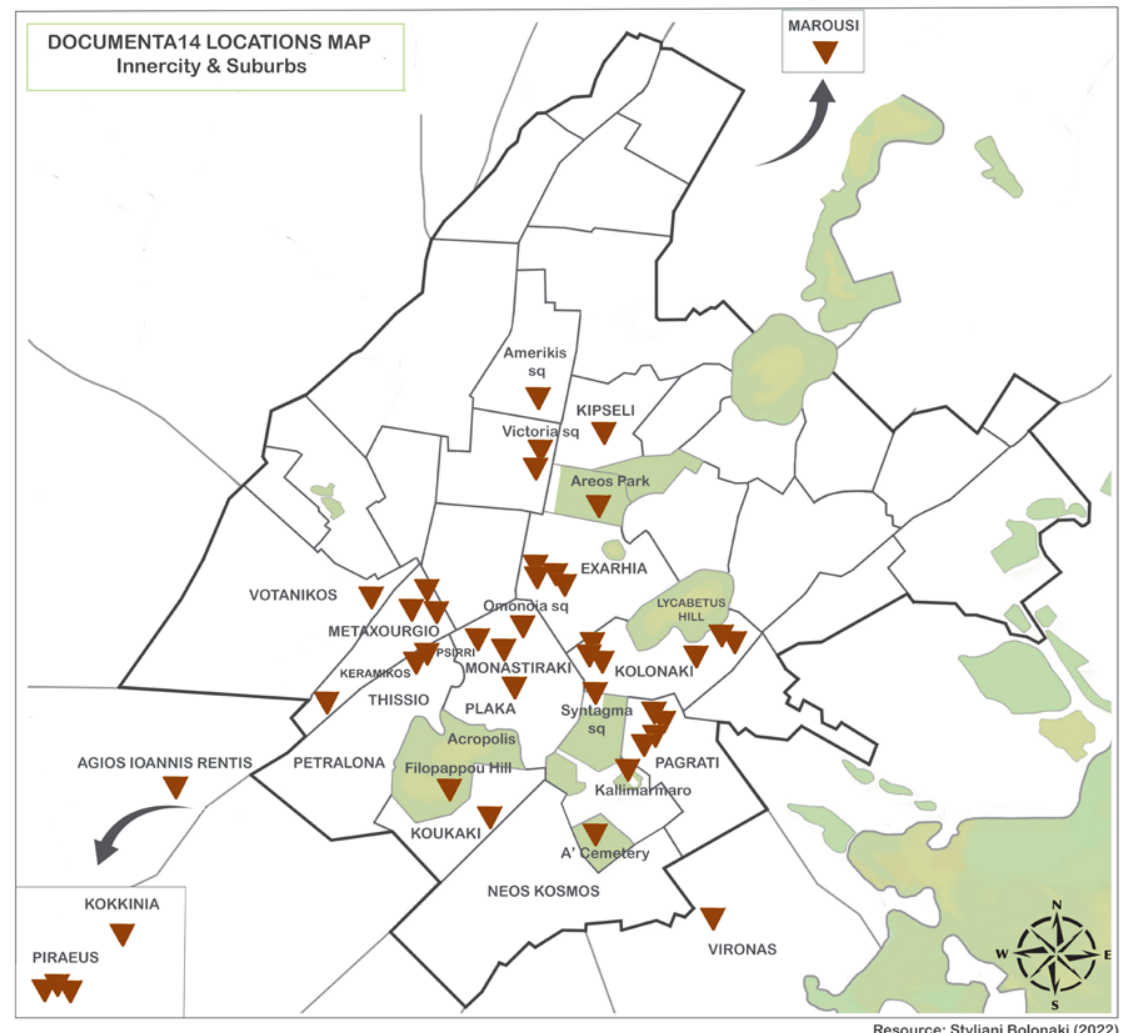
FIG. 2 “Documenta 14 locations map.” Design by Styliani Bolonaki